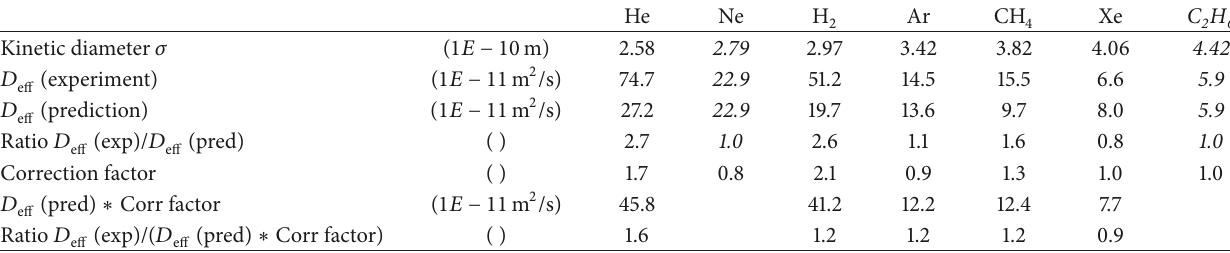
Table 9: Predicting the gas effective diffusion coefficients of sample K4 after measuring the Ne and C 2 H 6 (both in italic) effective diffusion coefficients. In a first phase, the prediction is based only on expression (14). Subsequently, this prediction is improved by multiplication with a “correction factor” (see Table 8), which takes into account the gas specific deviation between the experimental and the predicted value.